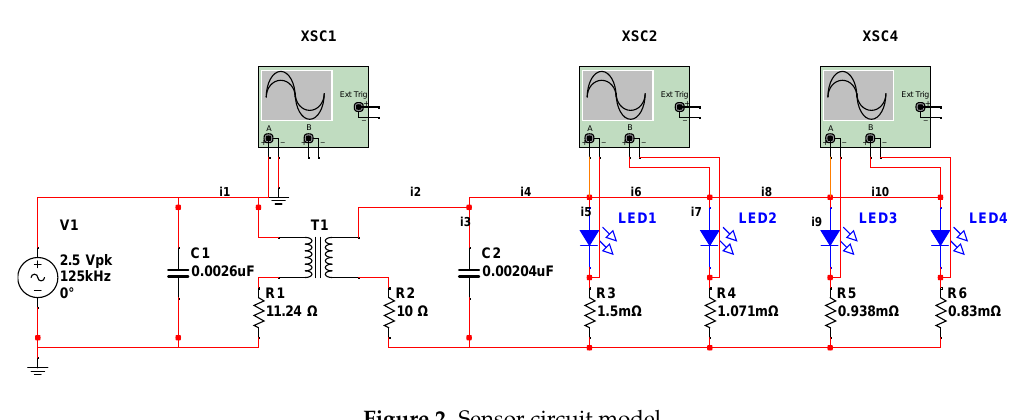
Figure 2. Sensor circuit